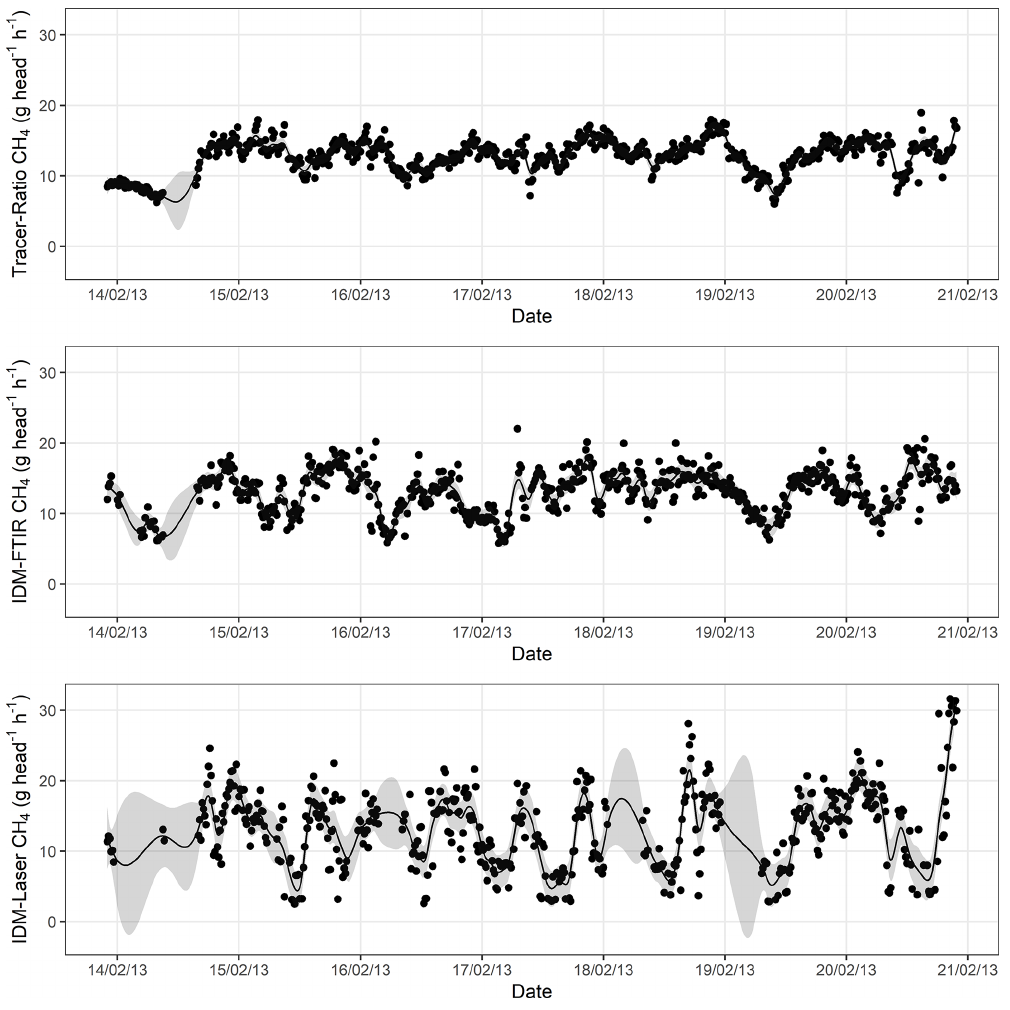
Figure A1. Time series of CH 4 emissions measured using the tracer-ratio, IDM-FTIR, and IDM-Laser methods. Black dots show the 15min measurements. The solid black line shows the mean value of gas emission estimated from a GAM fit to the measurement data. The shaded area represents the 95% credible intervals of the mean gas emission from the GAM fit (i.e. it contains 95% of the potential mean values of gas emission at a given